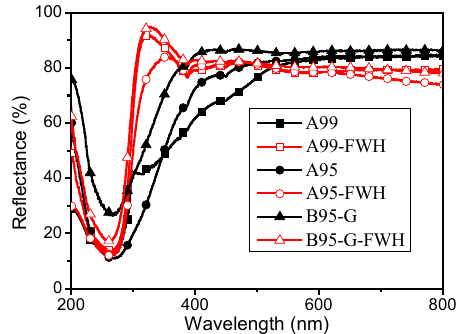
Fig. 7 Reflectance spectra of the alumina ceramics before and after firing in wet